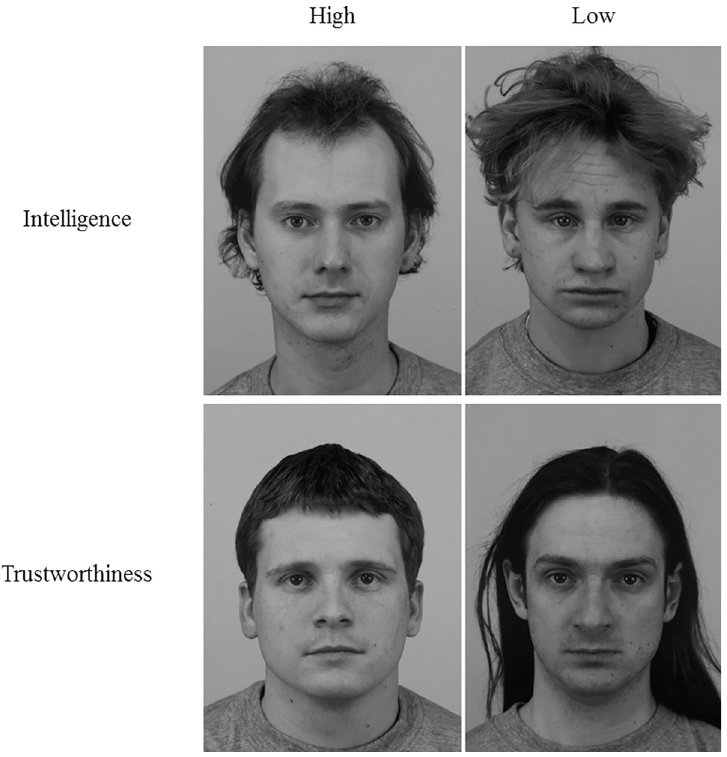
Fig 4. Study 2 “Real Faces”. All stimuli were taken from the Karolinska Directed Emotional Faces [37]. High Intelligence (ID: AM13), Low Intelligence (ID: AM32), High Trustworthiness (ID: AM31), Low Trustworthiness (ID: